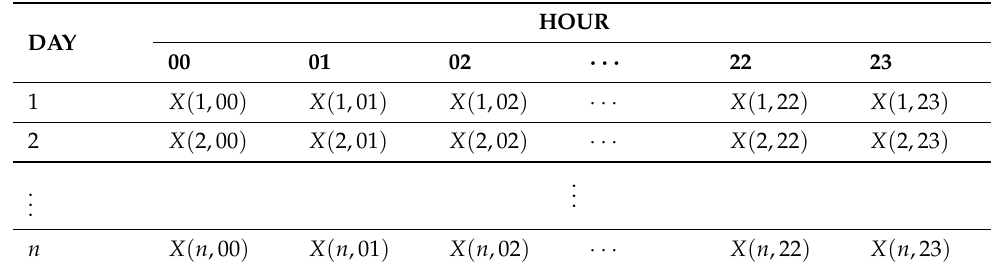
Table 1. Measurements organized by days and